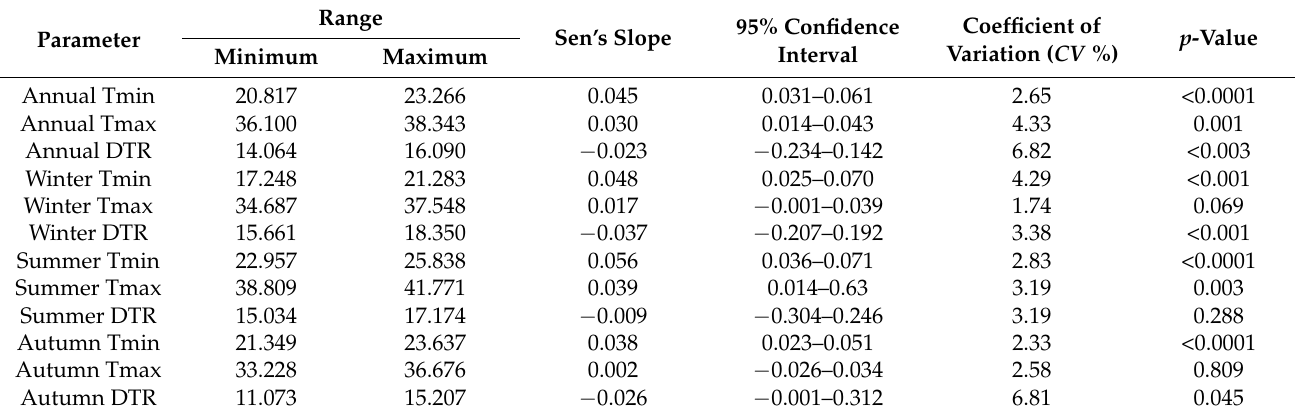
Table 1. Estimated Sen’s slope values for the annual and seasonal temperature ( ◦ C) trends at Gedaref state, Sudan between 1984–2018.